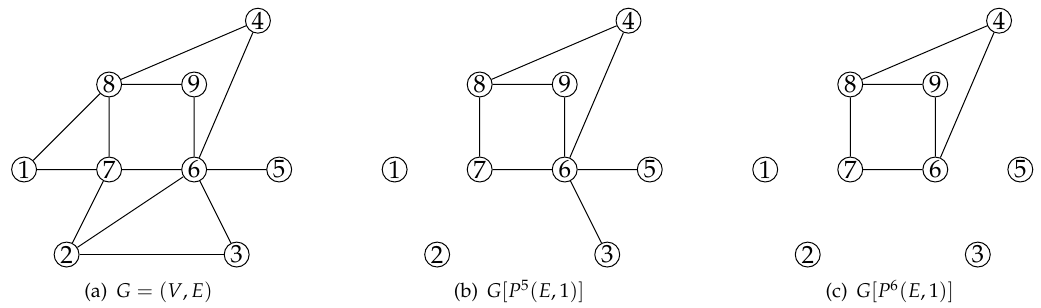
= 5 and = 6 (see Example L L